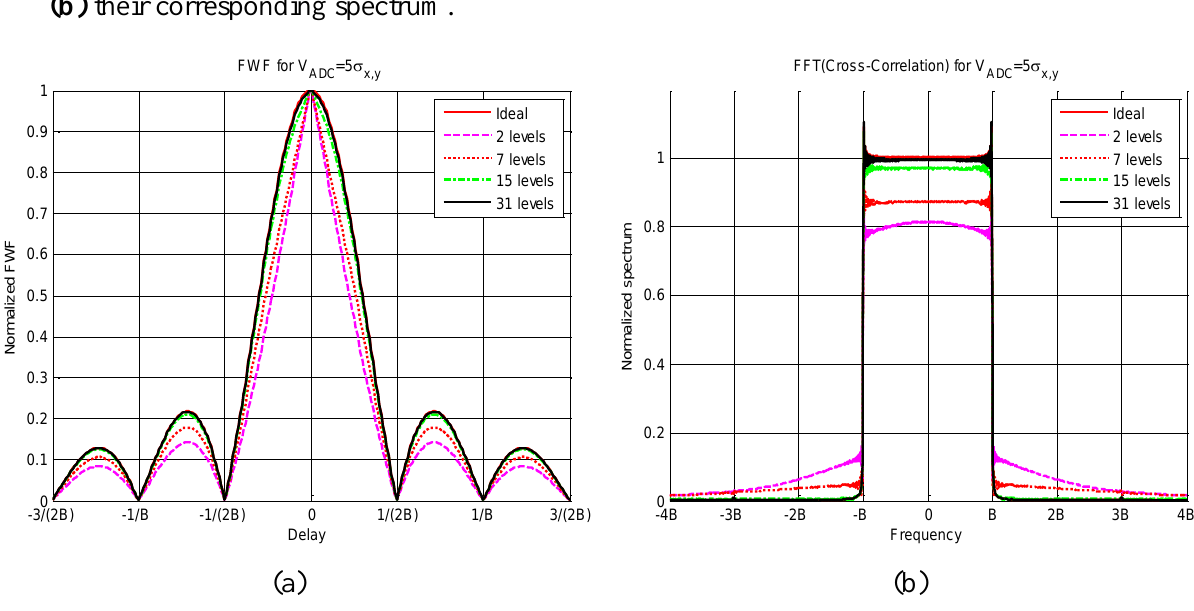
Figure 6. Effect of the quantization on the cross-correlation spectrum, (a) ideal cross-correlation ( ) and cross-correlation for different quantization levels, and (b) their corresponding spectrum.